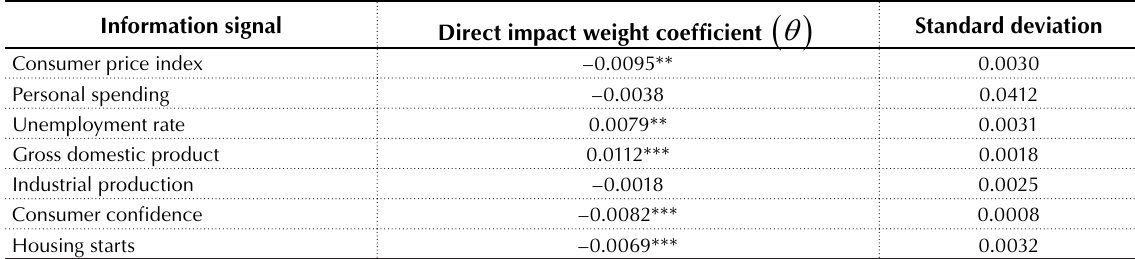
Table 9. The influence of the component of “surprise” on non-monetary information signals of the USA on the volatility of stock prices of enterprises of Ukraine in the economic sector